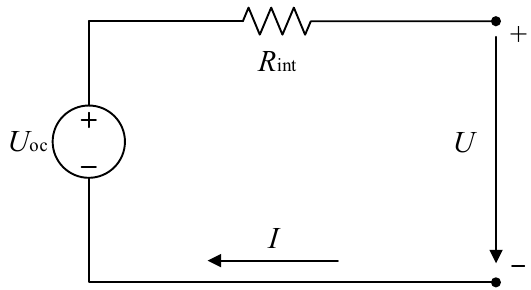
Figure 5. Equivalent circuit diagram of power battery.